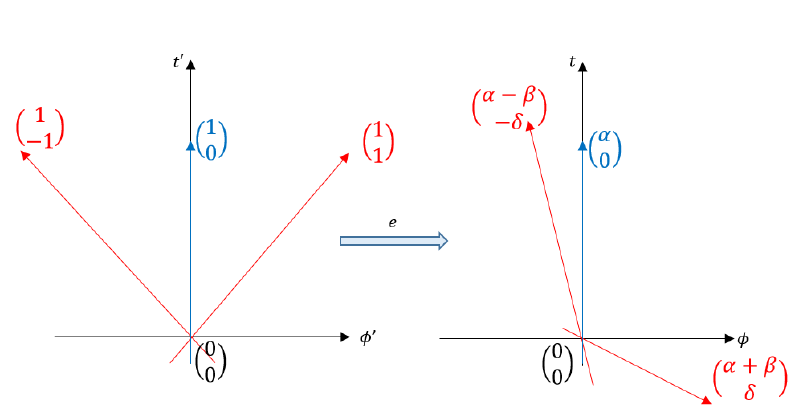
Figure 1. Schematic illustation (not to scale) of the transformation e that maps the Minkowski light cone to the light cone in rotating CTC spacetime. It is possible—as is illustrated here—that α + β is tilted so much forward that it tips below the spatial axis, giving rise to a CTC. In this case, α + β < 0, and the CTC is counter-rotating with respect to Ω < 0 (i.e., in the decreasing φ direction) and g t φ <